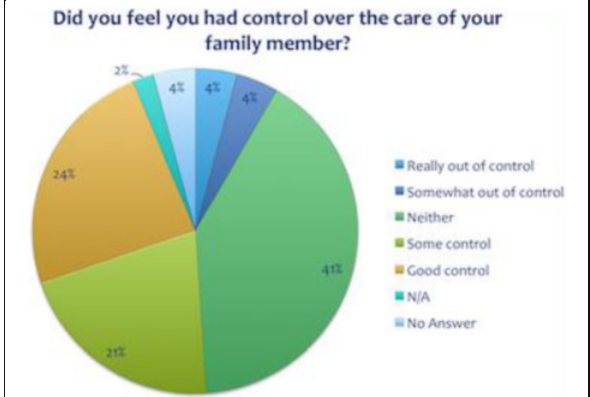
Fig. 94 (abstract A214). Control over the care of your family